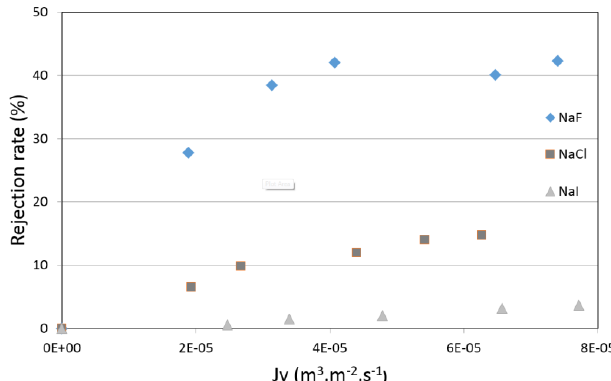
Figure 5. Rejection rate of pure salt-water solution (NaF, NaCl or NaI—5 × 10 −3 M) vs. permeation flux obtained with membrane 2.